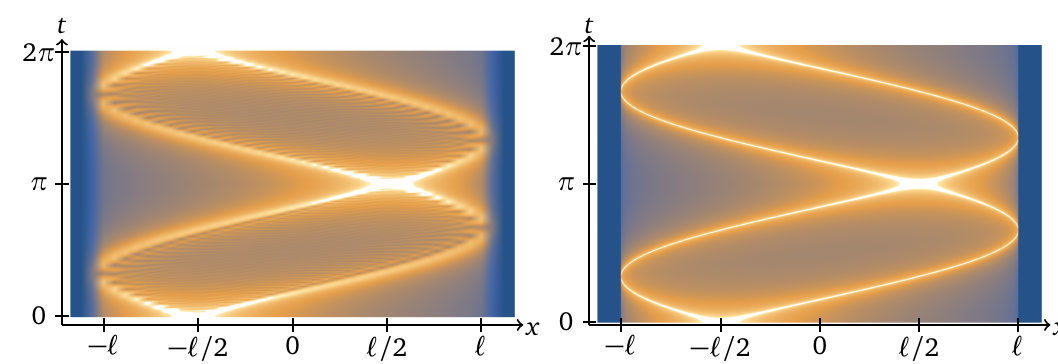
( − (cid:96)/ 2, t , x ,0 ) as a function of x and t . Left: Numerics for N = 160 (cid:112) 1 N . Right : CFT formula